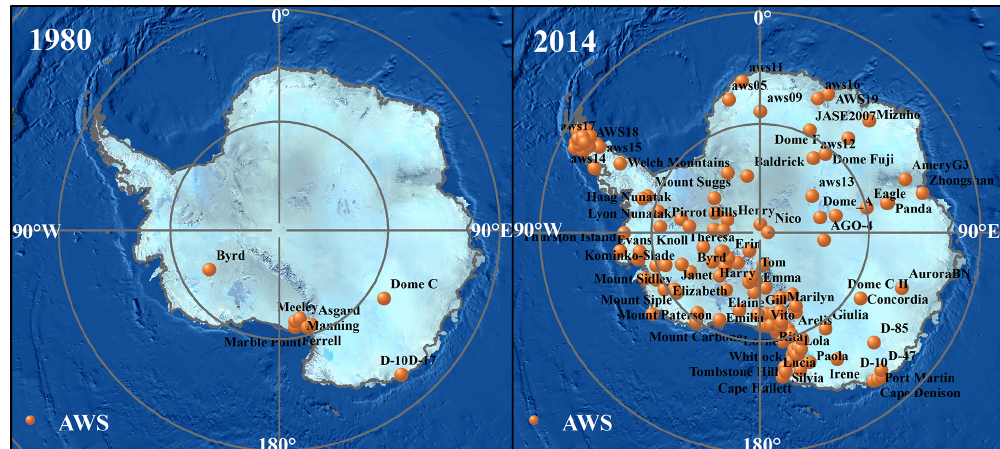
Figure 7. Spatial distribution of AWSs in 1980 and 2014.